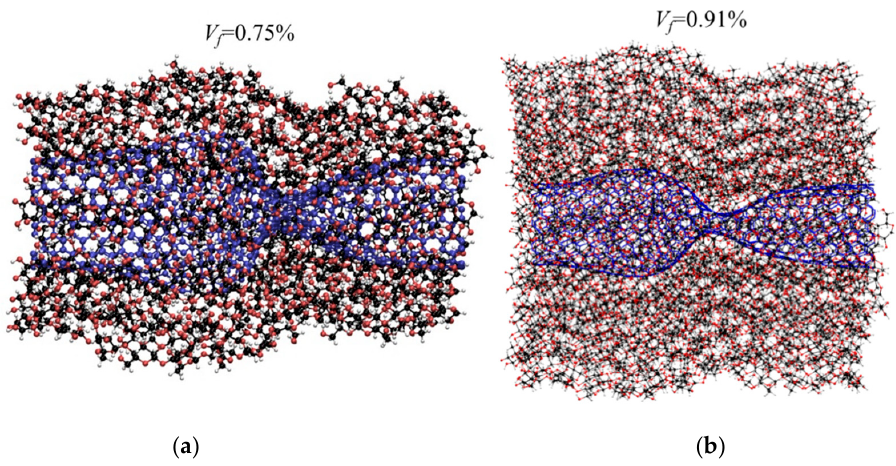
Figure 8. Buckling of CNT-wrapped cellulose during compression tests shows flattening of CNT. ( a ) V f = 75% and ( b ) V f = 91%.